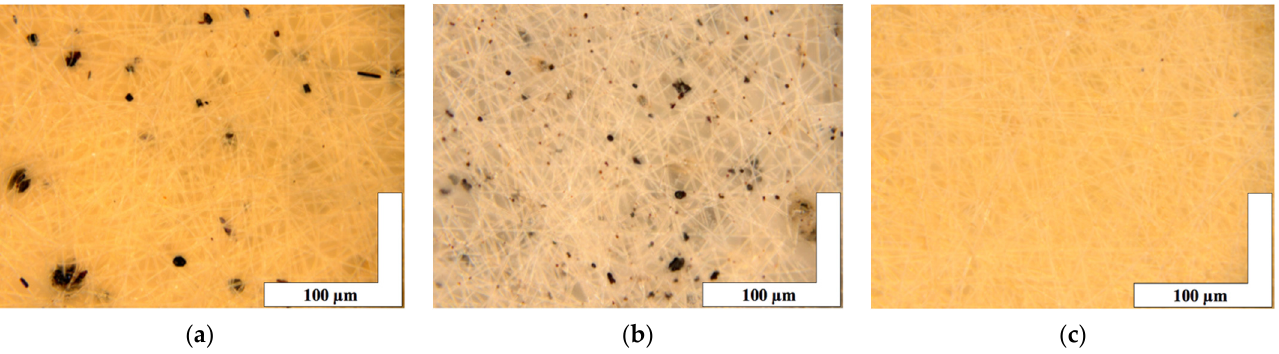
Figure 2. The microphotographs of PHB with different content of hemin: 1 ( a ), 3 ( b ) and 5 ( c ) wt. %.